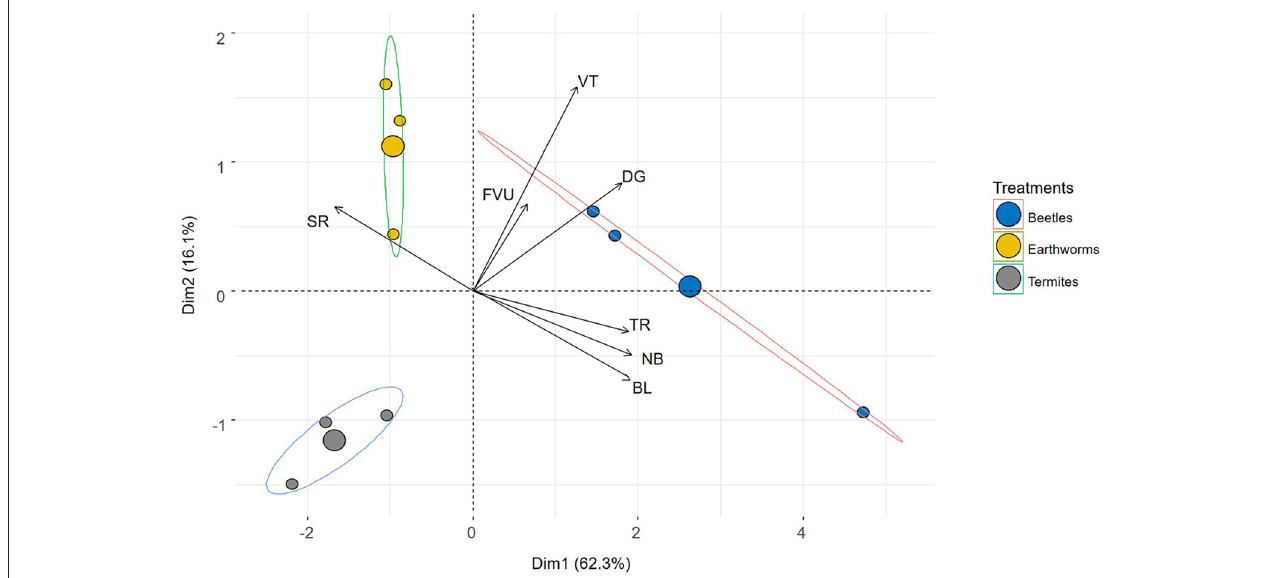
FIGURE 4 | Biplot showing the PCA made from the 3-D characteristics of galleries made by beetles, termites and earthworms. Variables include the diameter of galleries (mm) (DG), their tortuosity (–) (TR), sphericity (SR) (–), verticality ( ◦ ) (VT), total length of galleries 10 (mm) (BL), number of branches 10 (NB) (–), and fraction of galleries volume in upper part (FVU). The correlation circle is also given on the right side. Ordination of the samples is in the plane defined by axes 1 and 2 of the PCA. TABLE 3 | Influence of the treatments on the morphological characteristics of galleries created by beetles, earthworms and termites derived from X-ray CT image analysis. Treatments